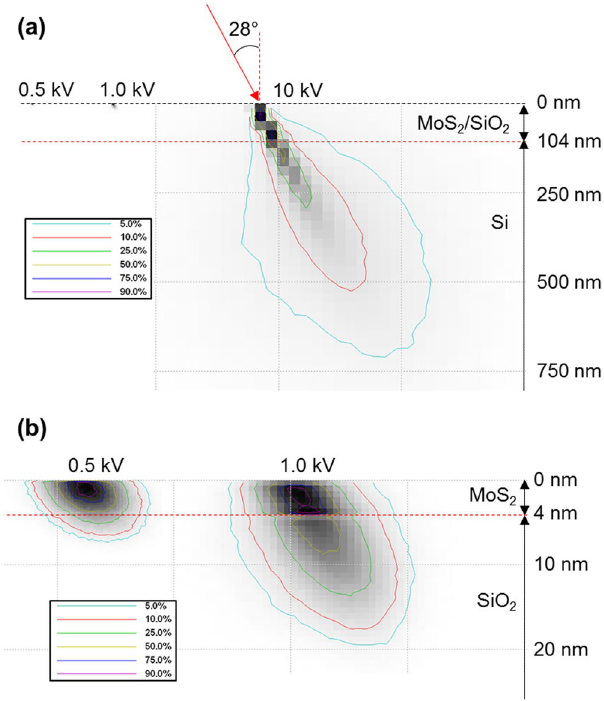
Figure 7. Energy absorption. ( a ) Cross-sectional view of the absorbed energy for the MoS 2 /SiO 2 /Si substrate according to incident electron energies of 0.5, 1.0, and 10 kV with an incident angle of 28° on the x – z plane. ( b ) Magnified image of the absorbed energy for the incident electron energies of 0.5 and 1.0